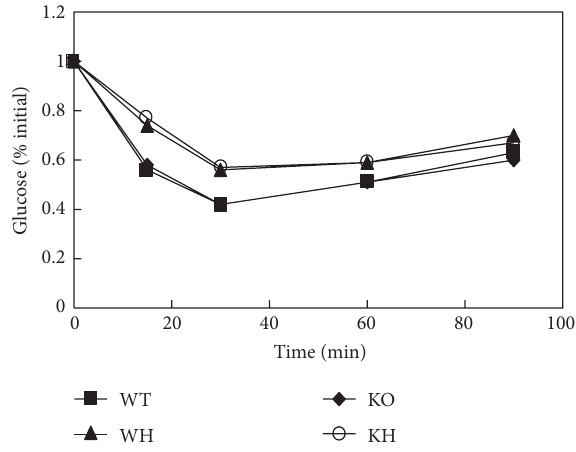
Figure 4: The curve of insulin tolerance test. WT: wildtype mice; WH: wildtype mice with high-fat diet; KO: ACE2 knockout mice; KH: ACE2 KO mice with high-fat